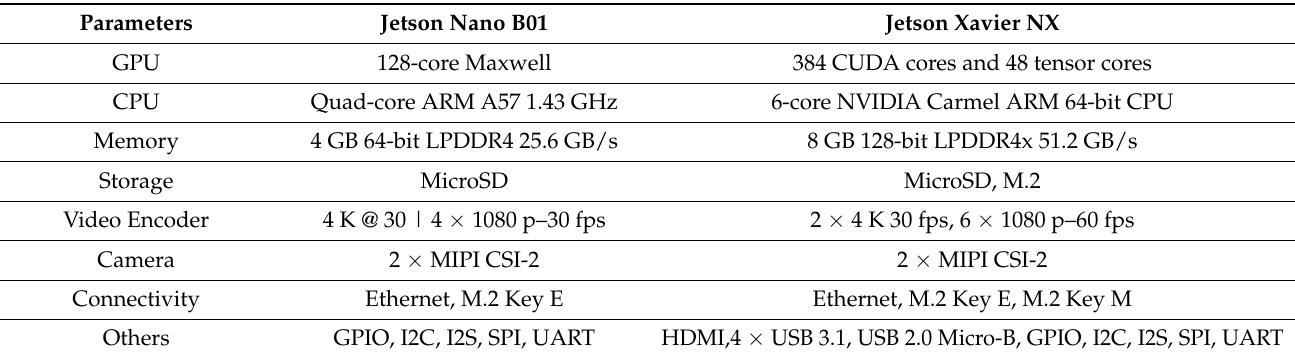
Table 4. Jetson Nano and Jetson Xavier NX technical